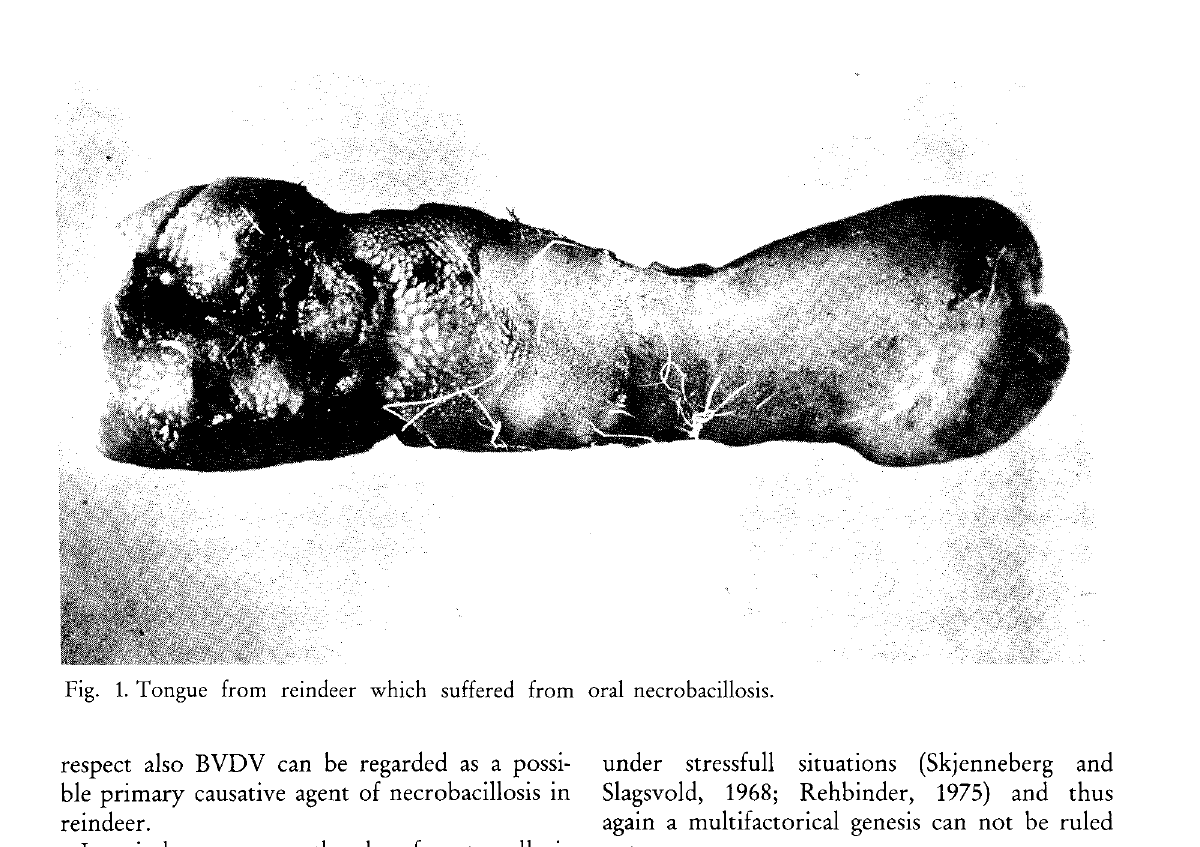
respect also B V DV can be regarded as a possi ble primary causative agent of necrobacillosis in